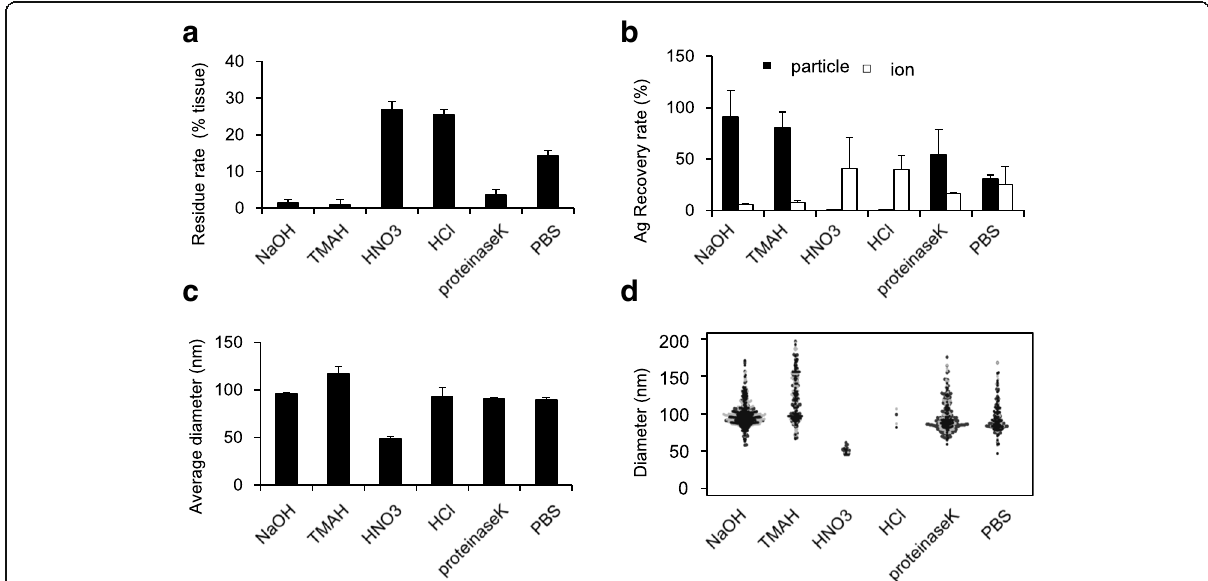
Fig. 2 NaOH pretreatment is the optimal method for detecting nAg100 in mouse liver. Five solubilizing reagents were screened as pretreatment solvents to lyse the tissues (NaOH, TMAH, HNO 3 , HCl, and proteinase K). The liver homogenate was mixed with nAg100 solution to obtain a final Ag concentration of 100 ng/mL and treated with each solubilizing reagent at 37 °C. After 3 h, a residue rates in each group as an indicator of tissue solubility, b recovery rates (black and white bars represent the rate of silvers detected as particles and as ions, respectively), c average particle diameters shown in a bar chart, and d particle size distribution shown in a beeswarm chart were analyzed by sp-ICP-MS analysis. The results are expressed as mean ± SD ( n =